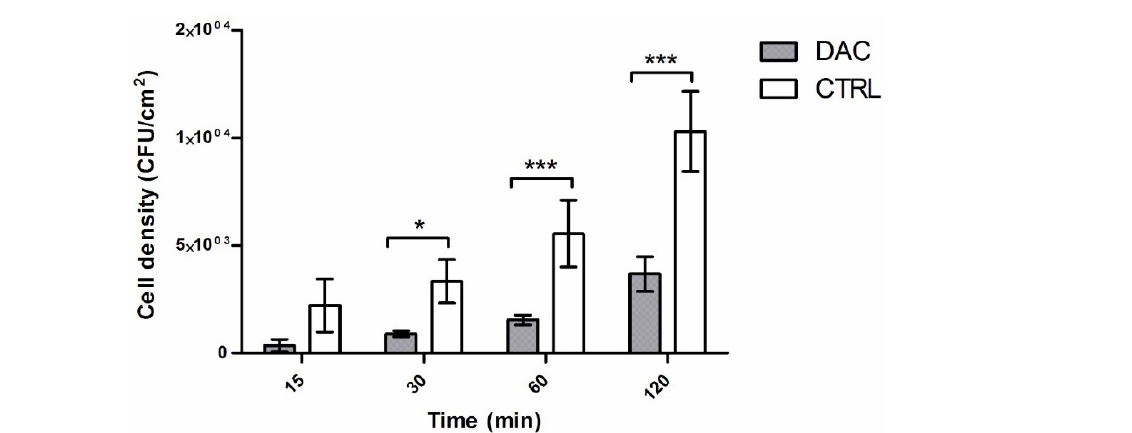
Figure 3. Adhesion densities of S. aureus (mean CFU/cm 2 ± standard deviation ) over time in pre-treated with DAC ® and control discs at 15, 30, 60, 120 min; * 0.01 < P <0.05, ** 0.001 < P < 0.01, *** P < 0.001 (two-way ANOVA followed by Bonferroni post hoc test).